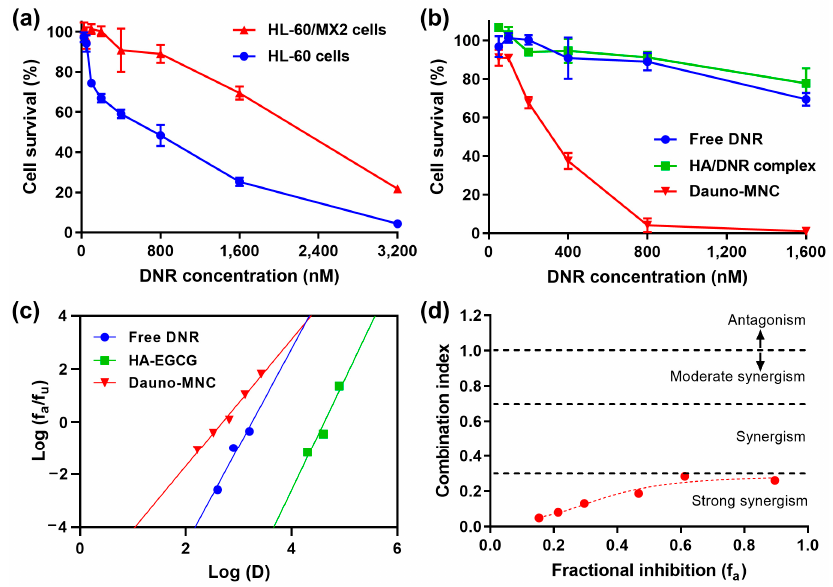
Figure 5. ( a ) Viability of HL-60 and HL-60/MX2 cells treated with free DNR at varying concentrations. ( b ) Cytotoxicity of Dauno-MNC, HA/DNR complex and free DNR against HL-60/MX2 cells. Mean ± SD ( n = 4). ( c ) Median-effect plots showing eradication of HL-60/MX2 cells treated with free DNR, HA–EGCG or their combination (Dauno-MNC). ( d ) Combination index plot.